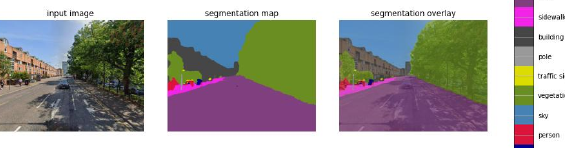
Figure 2 . Example output of GSV semantic segmentation.